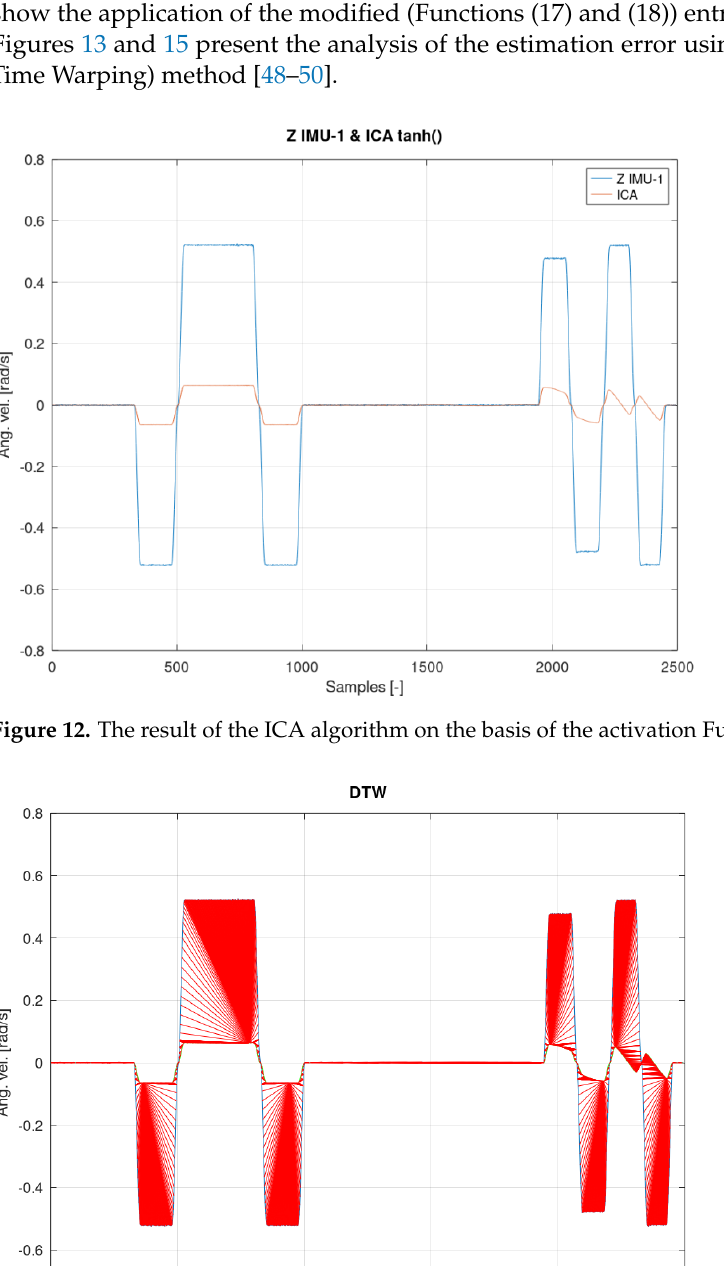
Figure 14. The result of the ICA algorithm on the basis of the activation Functions (17) and (18).